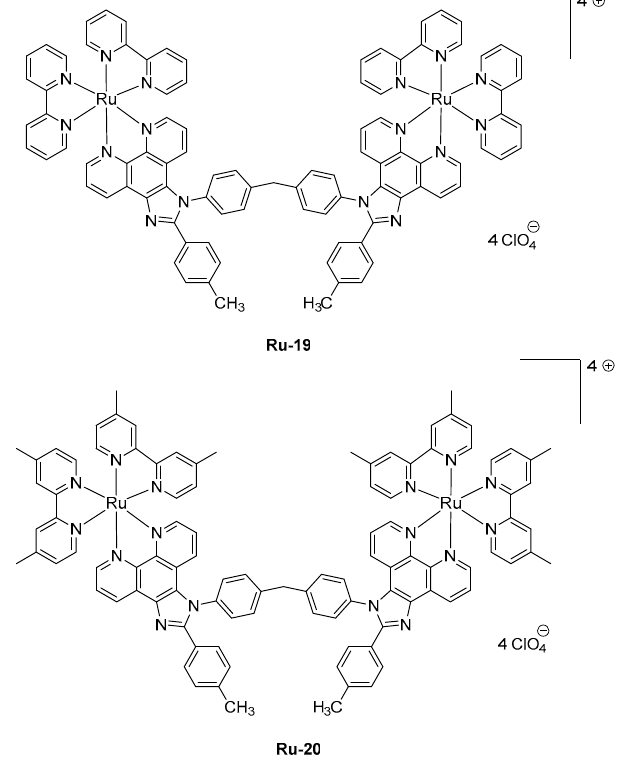
Figure 7. Ru-based near-infrared (NIR) emitters for light-emitting electrochemical cells.